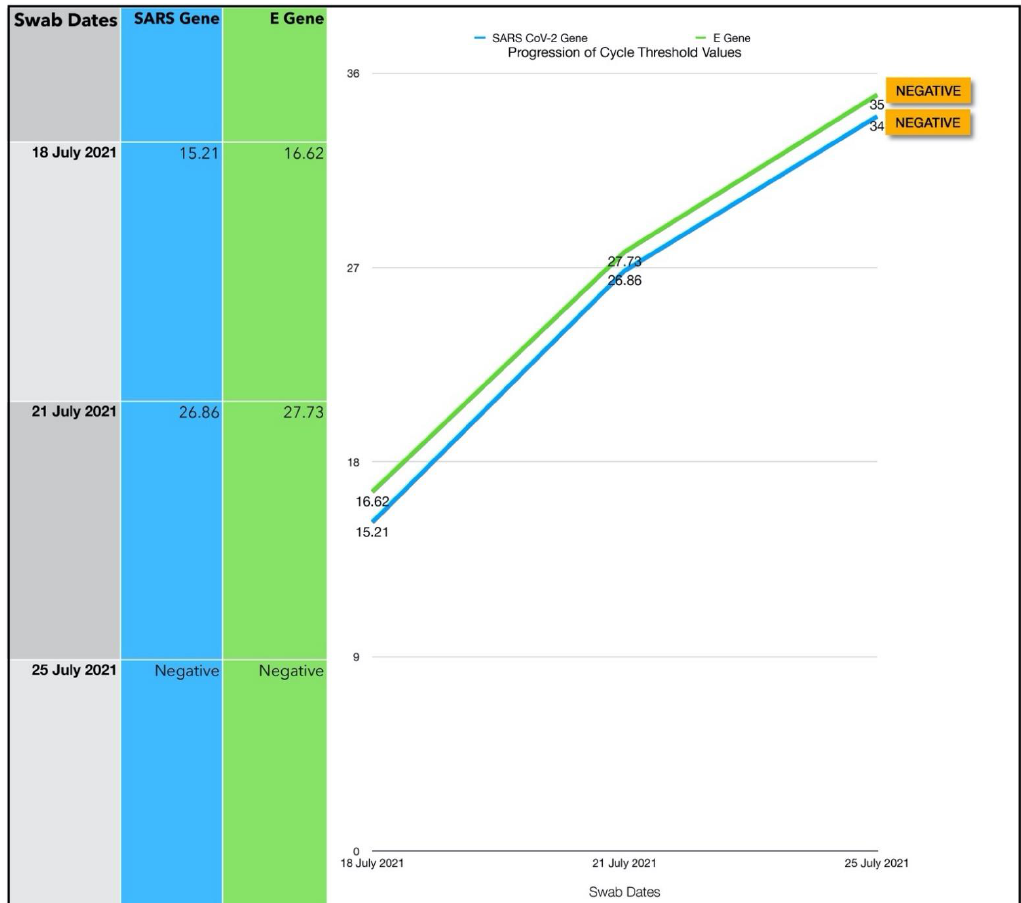
Figure 13. Shows the serial CT values of subject six.